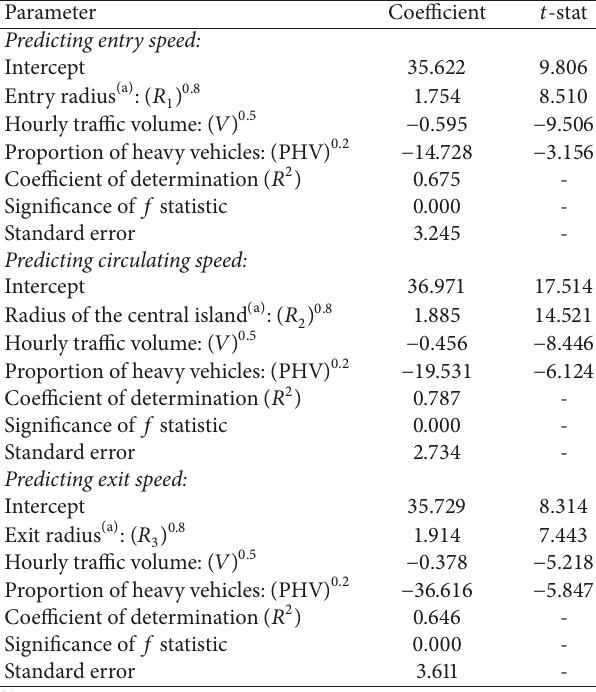
Table 3: Developed speed prediction